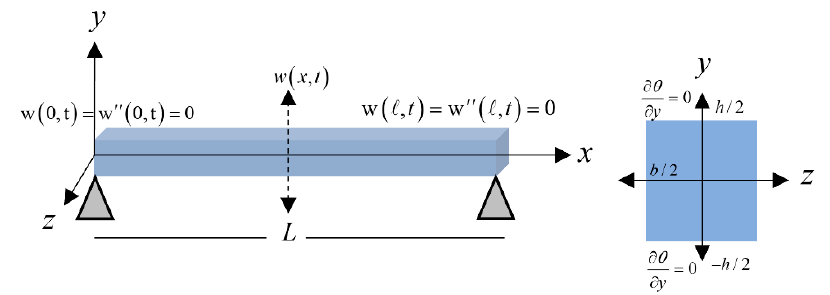
Figure 1. Nanobeam of silicon.